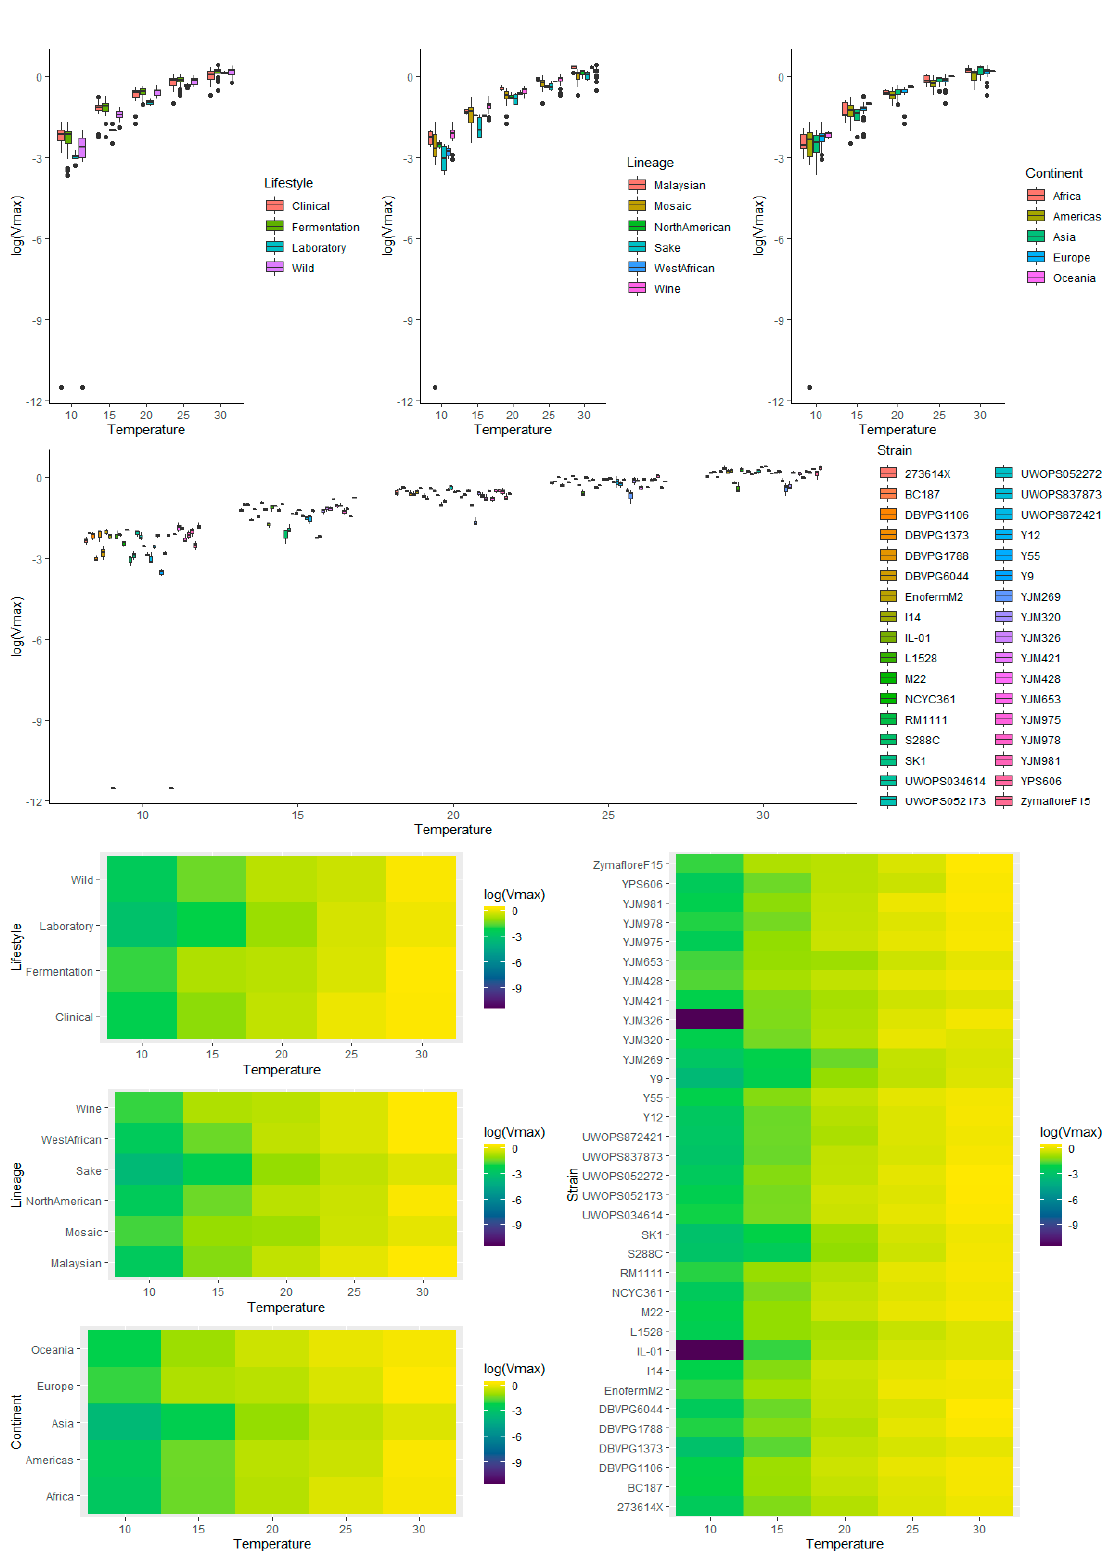
Figure 6. Box plots (top) and heatmaps (bottom) visualizing the interaction of temperature and each of the factors investigated (lifestyle, lineage, continent, and strain) on log-transformed fermentation V max